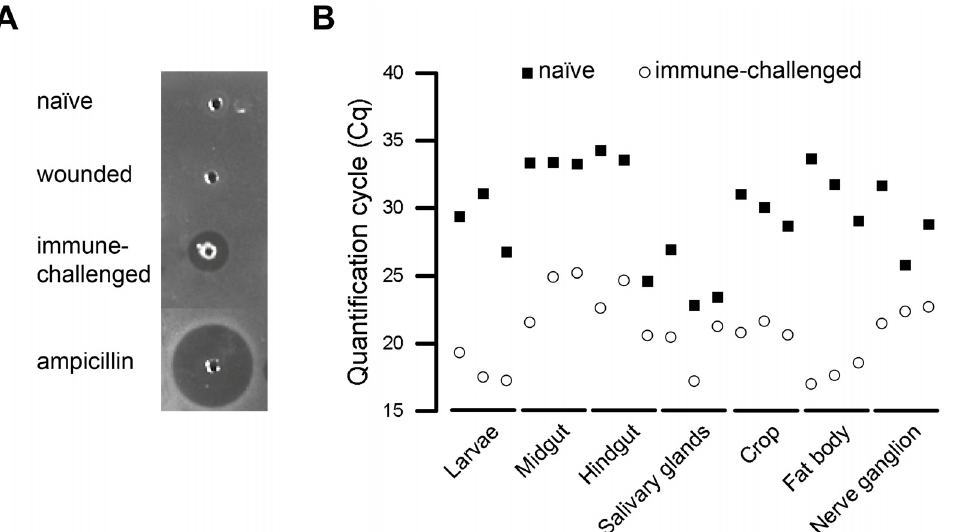
Fig 2. Validation of Pseudomonas aeruginosa immune challenge. A: Samples of hemolymph from na ï ve, wounded and immune-challenged larvae were tested in the E . coli zone of inhibition assay, with 100 mg/ml ampicillin as a positive control. Only immune-challenged larvae generated a zone of inhibition. B: Distribution of quantification cycle (Cq) values for immune gene attacin-2 in all na ï ve and immune-challenged samples. Raw values for all three biological replicates of the six tissue and the larvae samples are displayed separately.